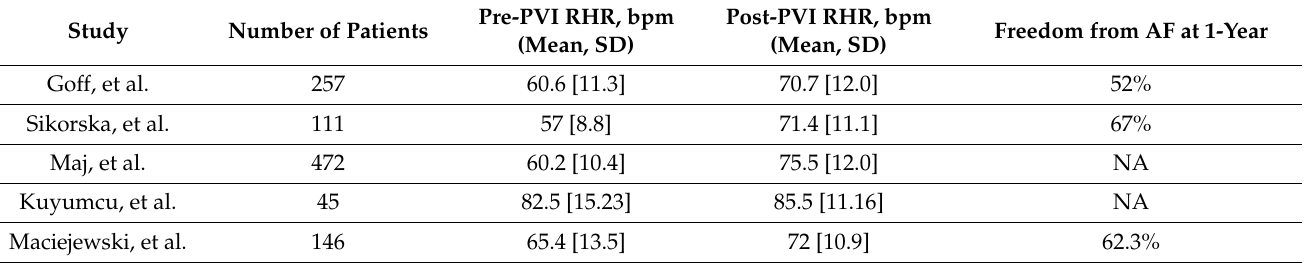
Table 5. Summary of the results of the studies evaluating the relationship between RHR change and PVI